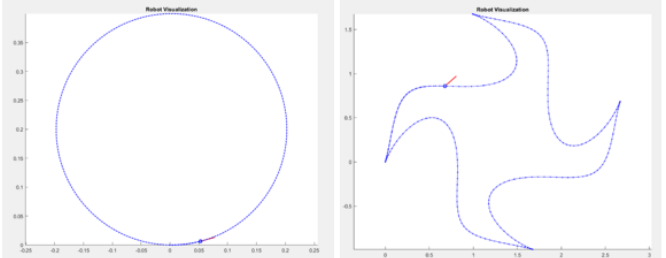
Fig. 12. Modeling